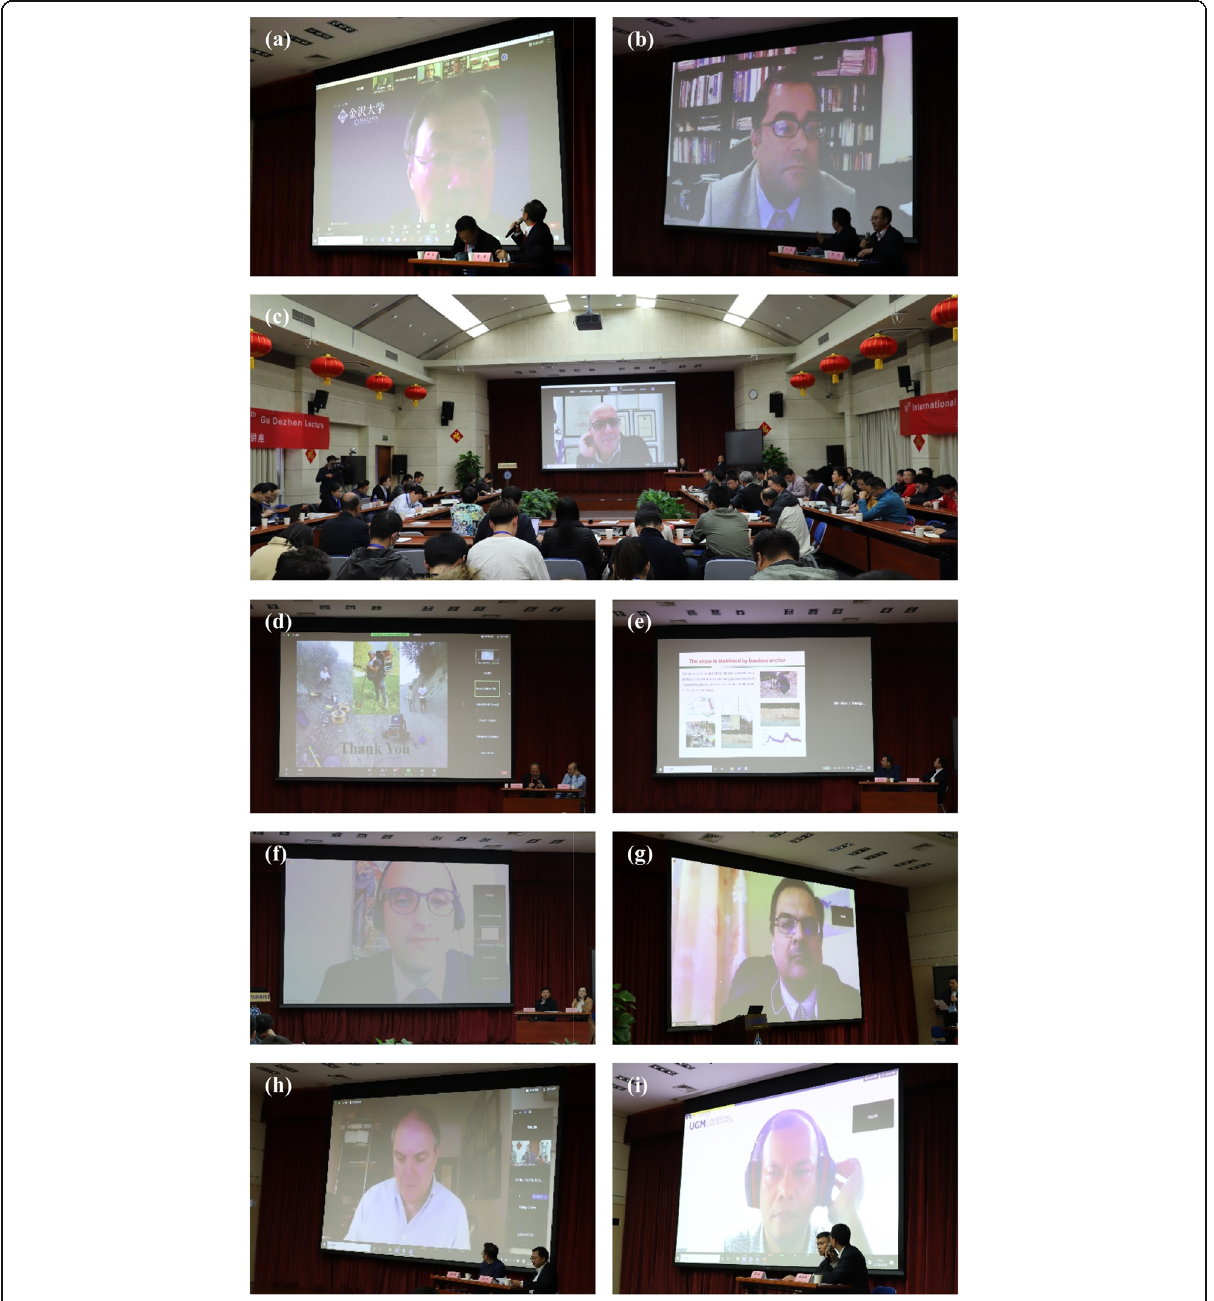
Fig. 5 Plenary lectures presented by Prof. Masakatsu Miyajima ( a ), Prof. Binod Tiwari ( b ), Prof. Nicola Casagli ( c ), Prof. Hans-Balder Havenith ( d